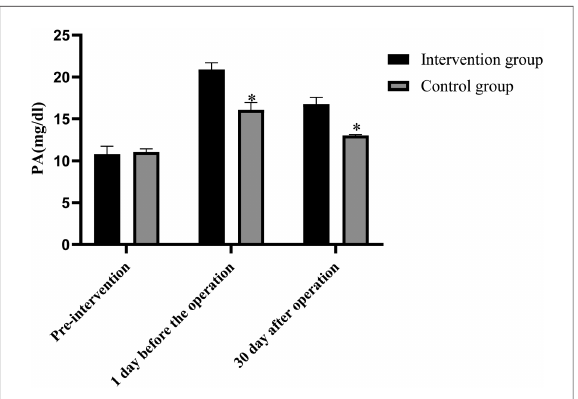
FIGURE 4 Comparison of PA levels between the two groups before and after intervention (Note: compared with the intervention group, * P <0.05).